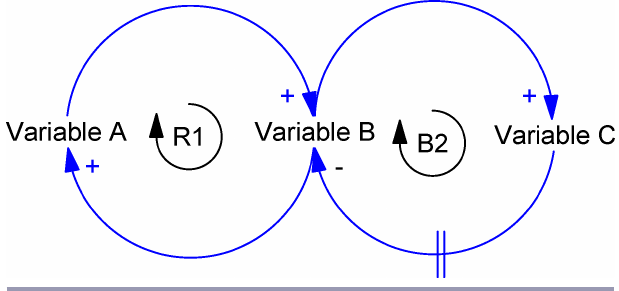
Fig. 1 . Basic structures of system archetypes: positive (+) and negative (-) connections. Only positive connections or an equal number of negative connections produces a reinforcing feedback loop (R1) while an unequal number of negative connections results in a balancing feedback loop (B2). The delay mark (II) indicates a time lag or partiality in connections